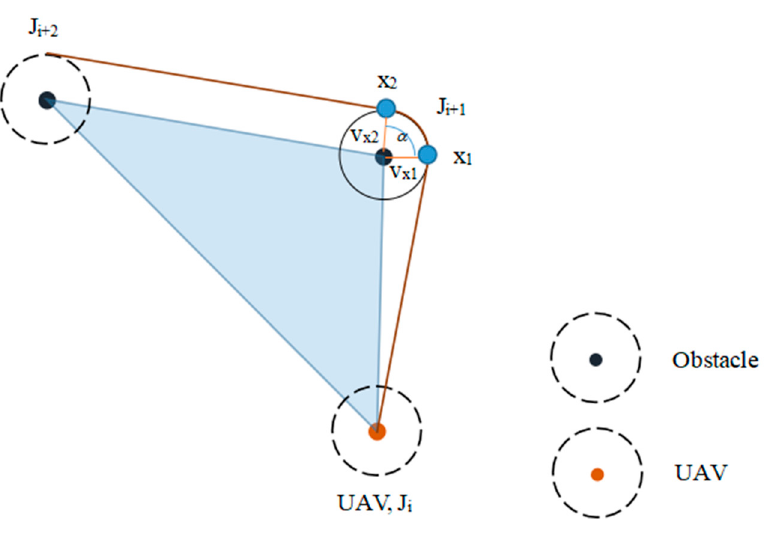
Figure 5. Path Selection for UAV Obstacle Avoidance.